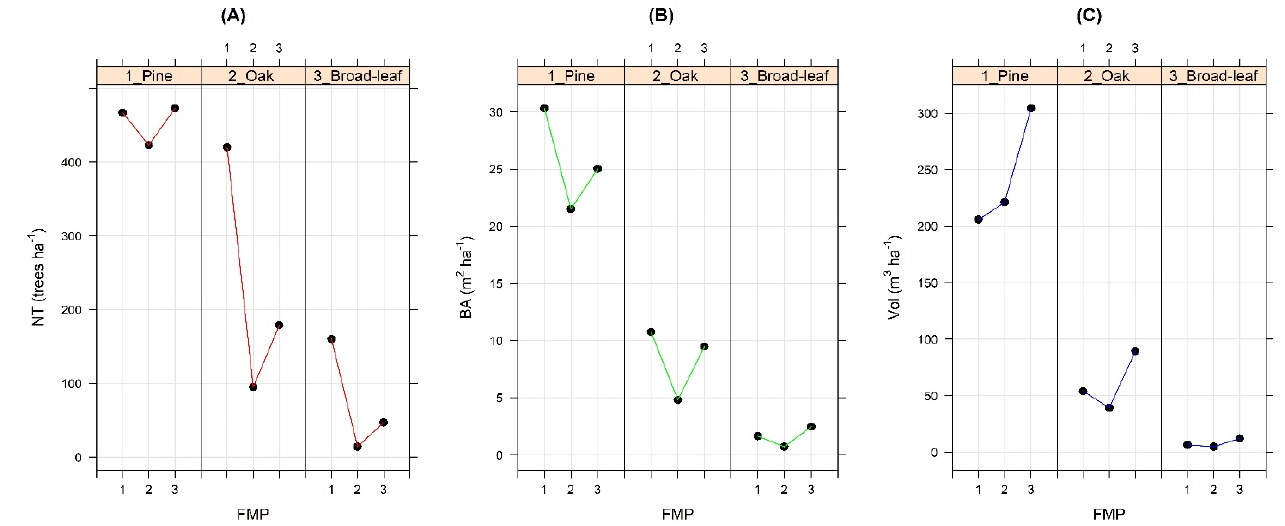
Figure 5. Comparison of number of trees ( NT ) ( A ), basal area ( BA ) ( B ), and volume ( Vol ) ( C ) of the three forest management plans (FMPs) in the H0202 sub-stand.